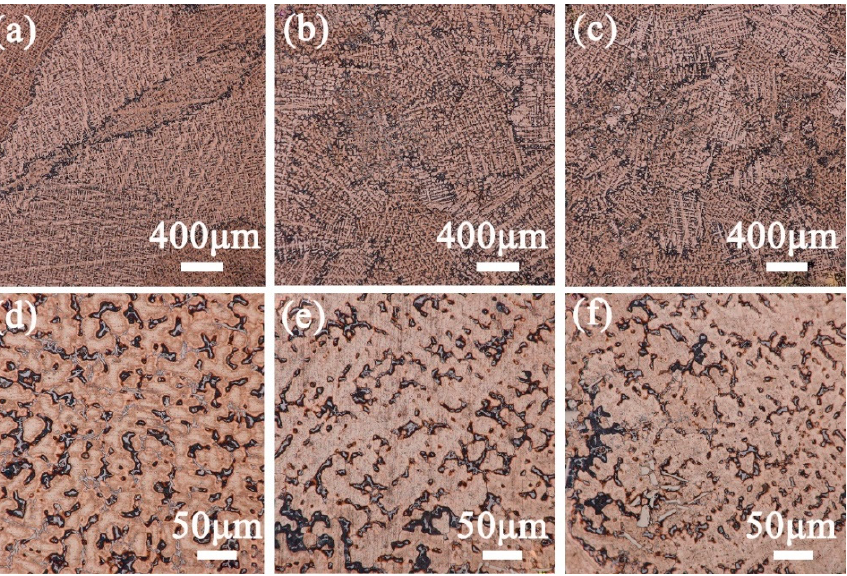
Figure 4. Metallurgical structure of as-cast Cu–15Ni–8Sn–xMo alloys with different Mo content: ( a , d ) 0.3, ( b , e ) 0.9, ( c , f ) 1.5